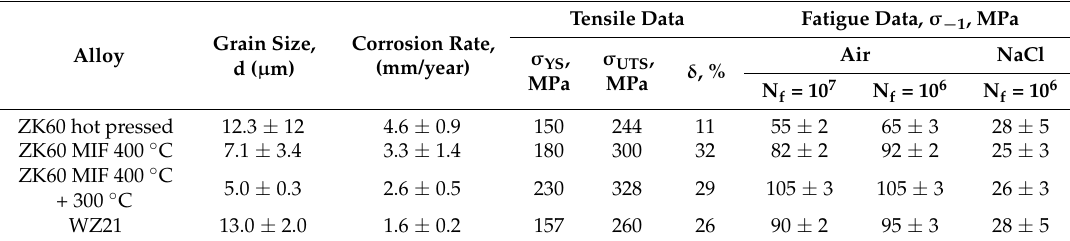
Table 1. Properties of Mg alloys tested.